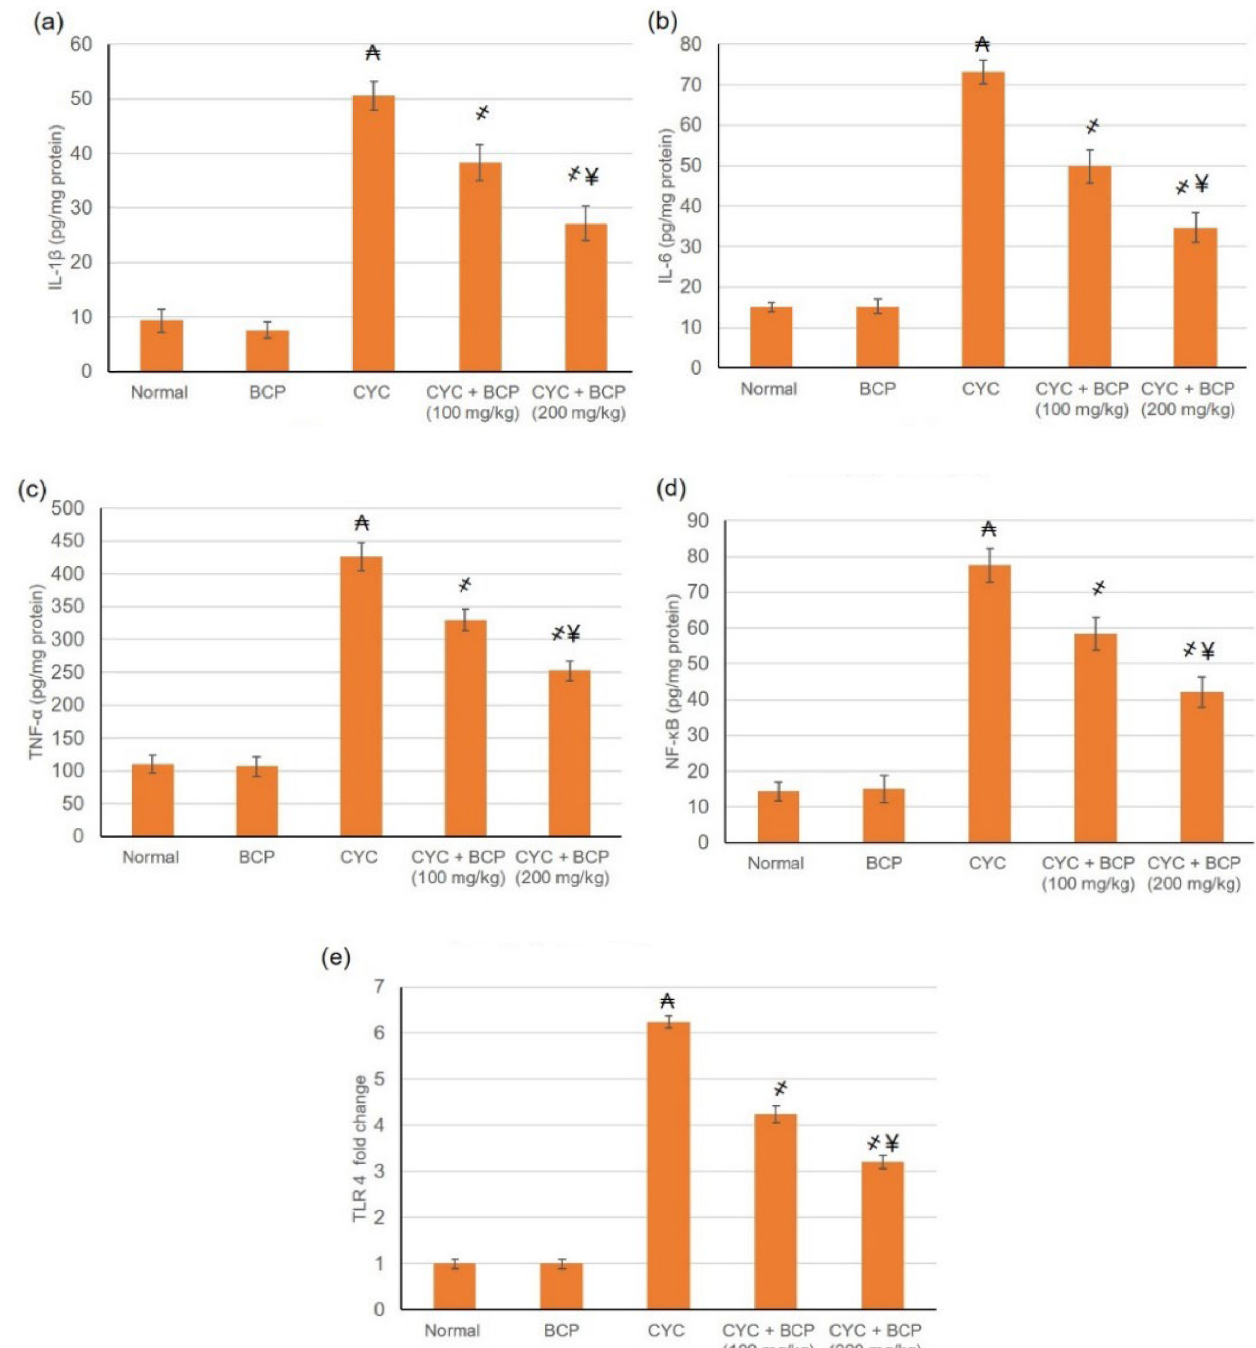
Table 1. Effects of treatment with β -caryophyllene (BCP) for 14 days on cyclophosphamide (CYC) induced fluctuations in body and heart weights and heart to body weights ratio in rat.